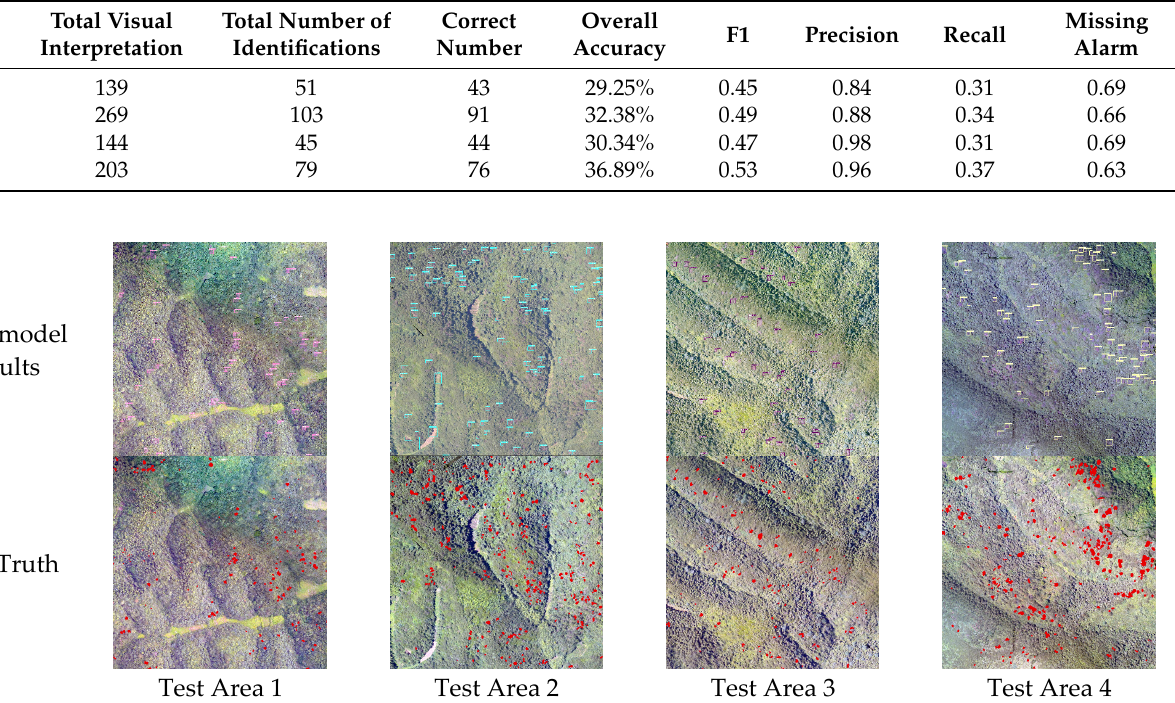
Table 4. The accuracy identification using YOLOv5.